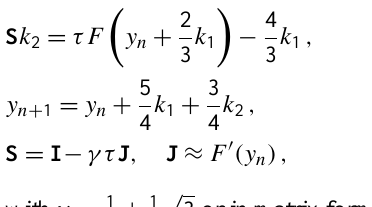
Figure 6. Terminal fall velocity of raindrops after Eq. (56).